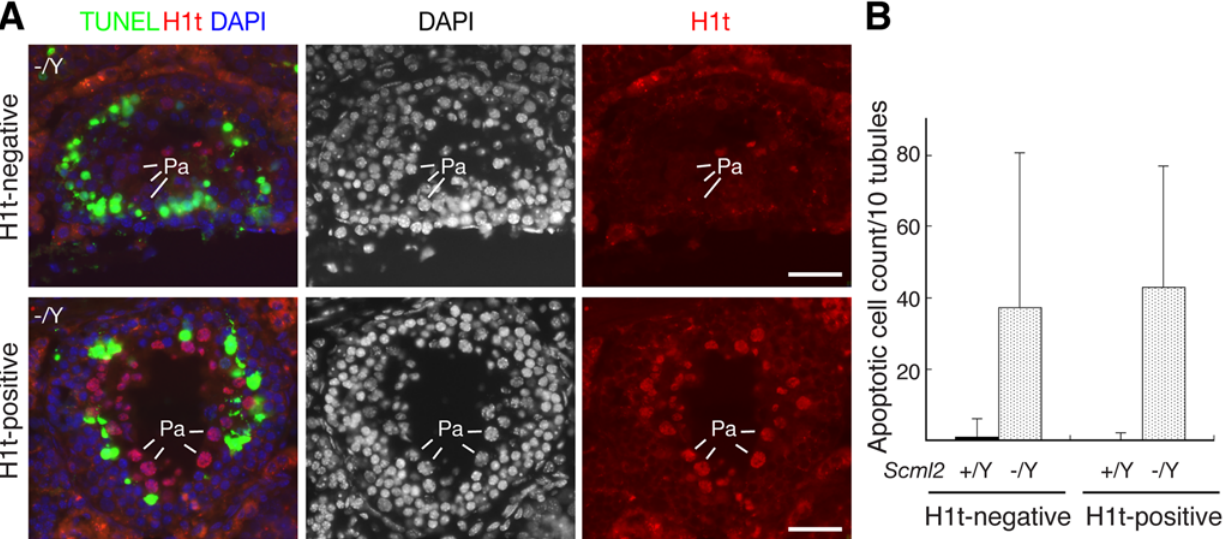
Figure 3. Apoptosis of spermatocytes in adult Scml2 -/Y testes. Based on the expression of histone H1t in pachytene spermatocytes, seminiferous tubules were divided into two groups: H1t-negative (early pachytene stage) and H1t-positive (mid-late pachytene stage). The number of TUNEL-positive cells per tubule cross-section was counted. (A) Apoptosis in both H1t-negative and H1t-positive Scml2 -/Y seminiferous tubules. Apoptotic cells presumably corresponded to pachytene spermatocytes. Pa: pachytene spermatocytes. Scale bars, 25 μ m. (B) Count of apoptotic cells. 100 tubules from adult Scml2 -/Y testes and 239 tubules from wild type testes were